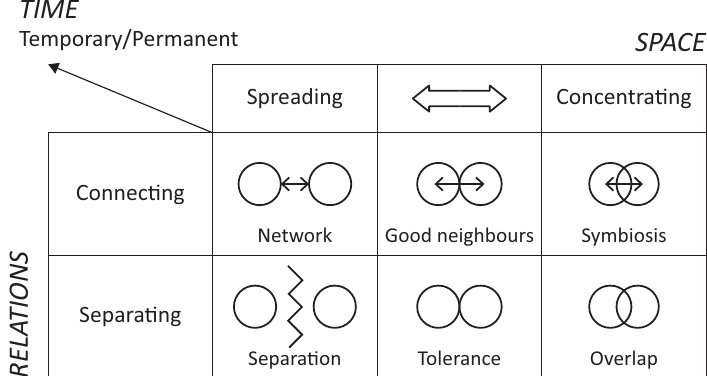
Figure 2. Typology of mixed‐use as proposed by Leinfelder and Pisman (2008, p. 4). high‐intensity mix of uses (“symbiosis;” Leinfelder & Pisman, 2008). Nonetheless, it seems that the more intense modes of mix‐use regularly reoccur in productive city discourses and projects, as indicated before. In par‐ ticular, vertical symbiosis seems to serve as a guiding image in design competitions.